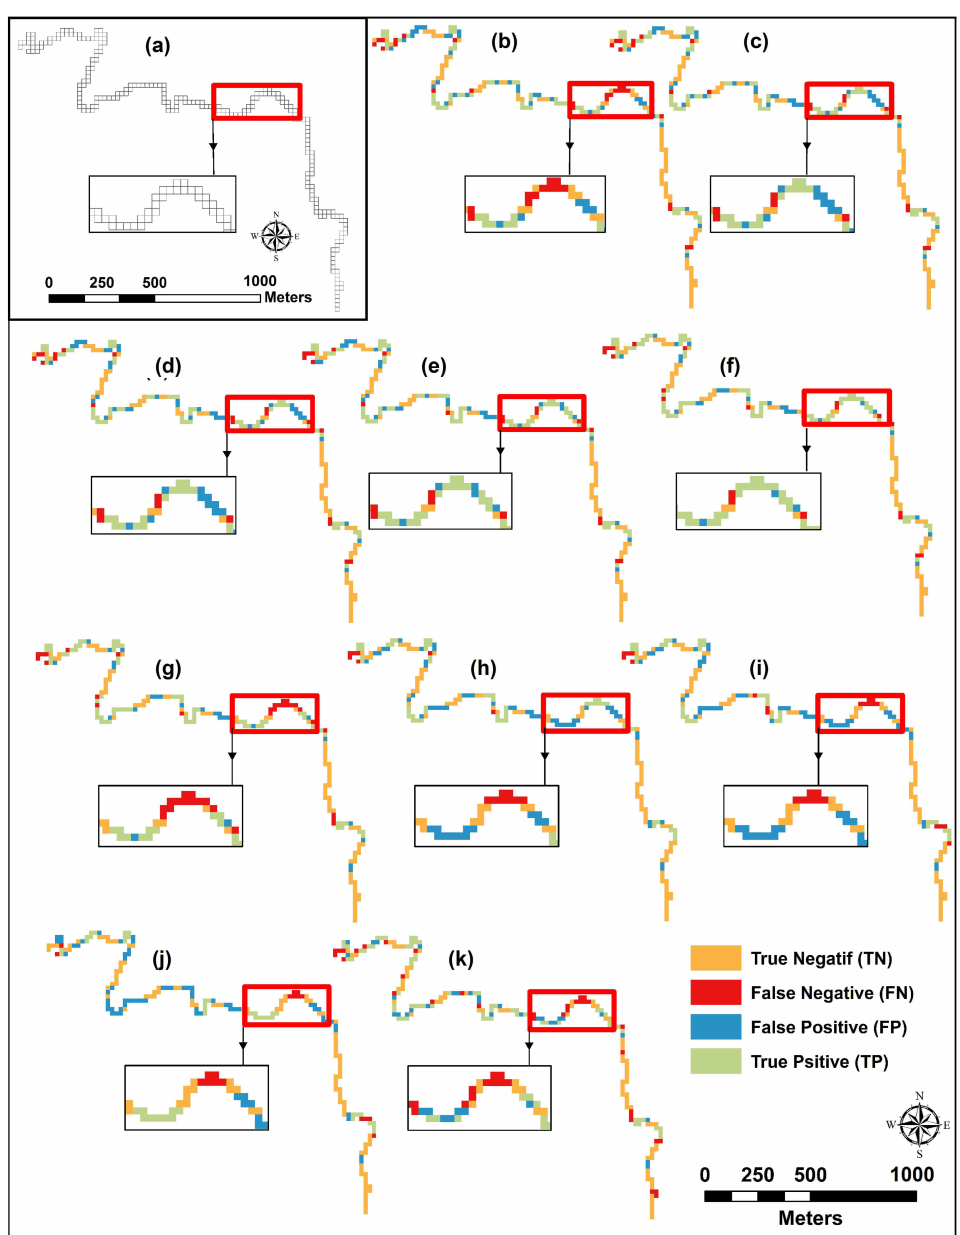
Figure 8. Sampling units (10 × 10 m) for the control and test groups in the study area ( a ). Spatial data accuracy without generalization tolerance ( b ), Douglas-Peucker generalization tolerance values: 20 cm ( c ), 40 cm ( d ), 60 cm ( e ), 80 cm ( f ), 1 m ( g ), 2 m ( h ), 3 m ( i ), 4 m ( j ) and the map displaying true/false distributions for the forest road with Bezier algorithm generalization ( k